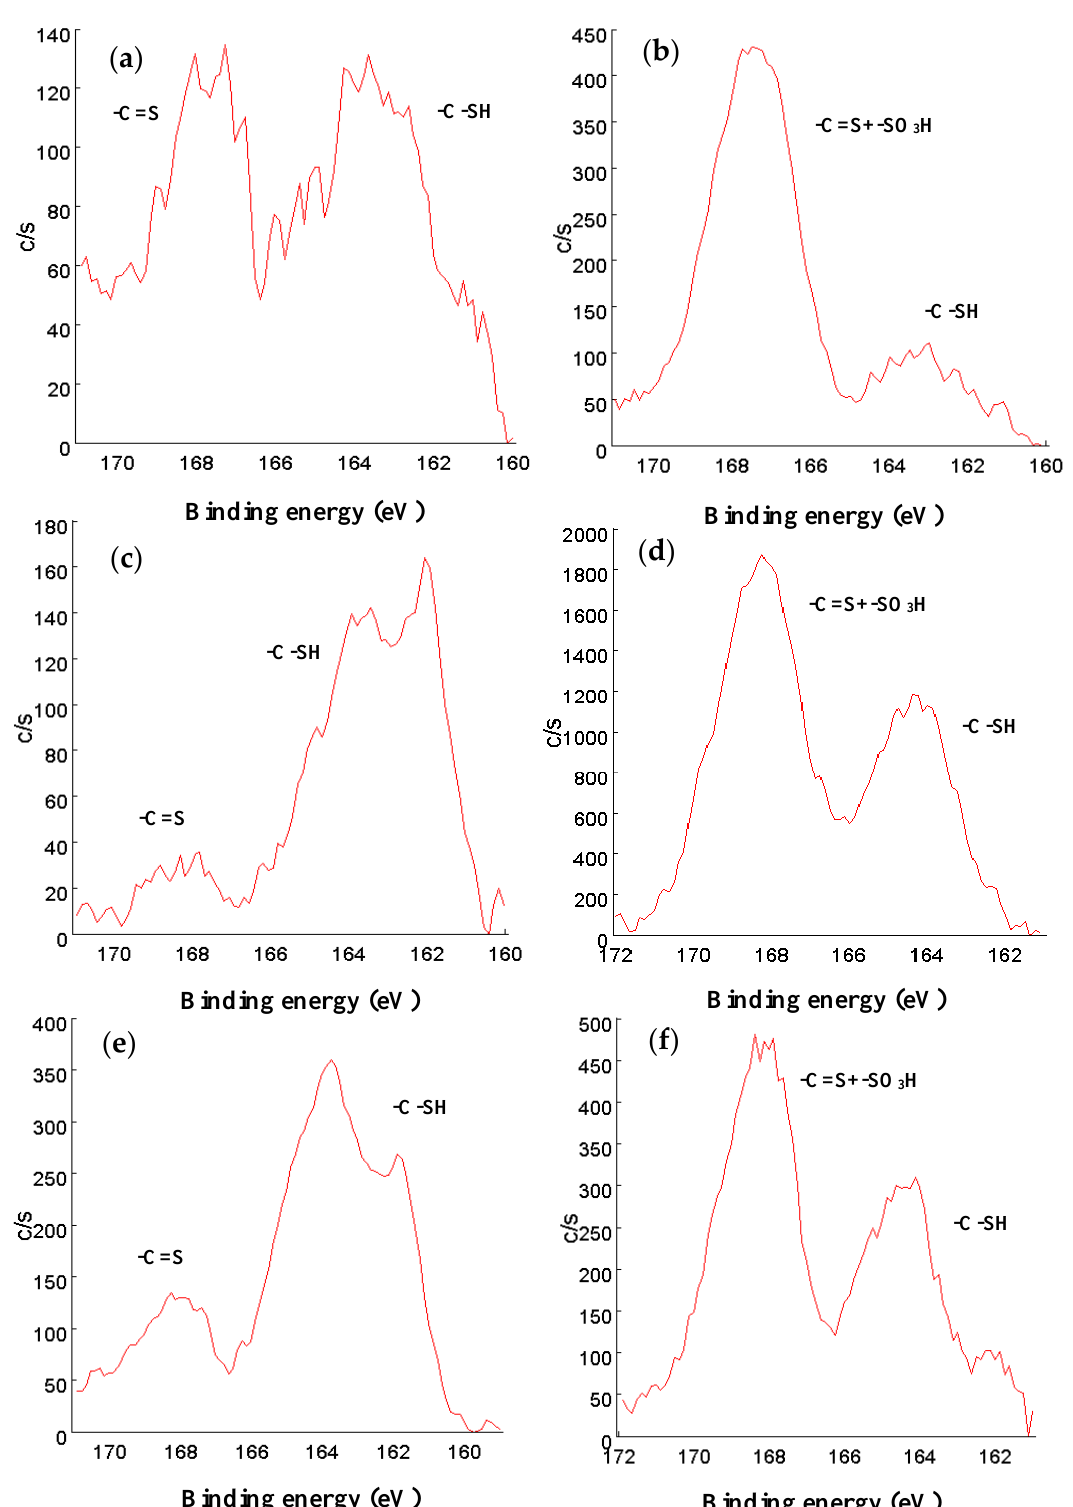
Figure 7. XPS sulfur spectra of ( a ) 1-DPTH; ( b ) 1-PSTH; ( c ) 2-DPTH; ( d ) 2-PSTH; ( e ) 3-DPTH; ( f ) 3-PSTH. Binding energy (eV) on x axis, and intensity of the signals (c/s) on y axis.